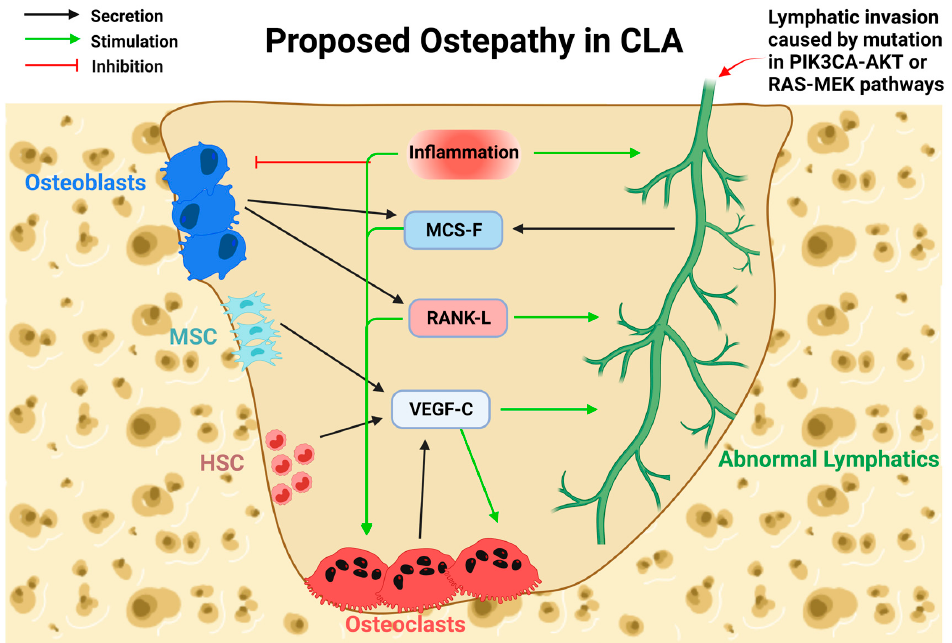
Figure 4. Proposed mechanism of bone loss in CLAs. Cytokines normally secreted by bone cells and lymphatics would stimulate bone resorption during lymphatic invasion. Lymphatic invasion, caused by activating somatic mutations, enables direct contact with bone and triggers resorption. Osteoblasts (OB) secrete M-CSF and RANK-L, which would stimulate Osteoclast (OC) function and lymphatic invasion. Mesenchymal Stem Cells (MSC) and Hematopoietic Stem Cells (HSC) secrete VEGF-C and stimulate OC function and lymphatic invasion. OC secretion of VEGF-C stimulates OC differentiation and lymphatic invasion. Lymphatic secretion of M-CSF stimulates OC differentiation. Inflammation containing various cytokines known to inhibit OB while stimulating OC differentiation and function. Inflammation positively regulates lymphangiogenesis of normal